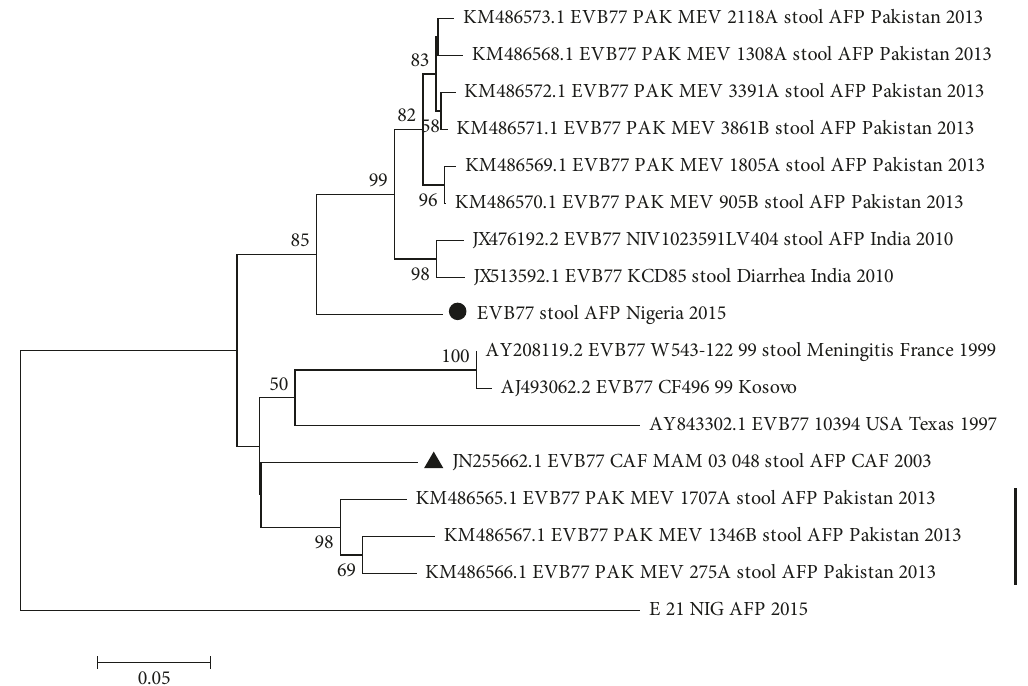
Figure 2: Phylogram of EV-B77. The phylogram is based on an alignment of partial VP1 sequences. The newly sequenced strains are highlighted with black circle. The strain previously recovered from Sub-Saharan Africa in 2003 is indicated with black triangle. The GenBank accession numbers of the strains are indicated in the phylogram. Bootstrap values are indicated if > 50%.